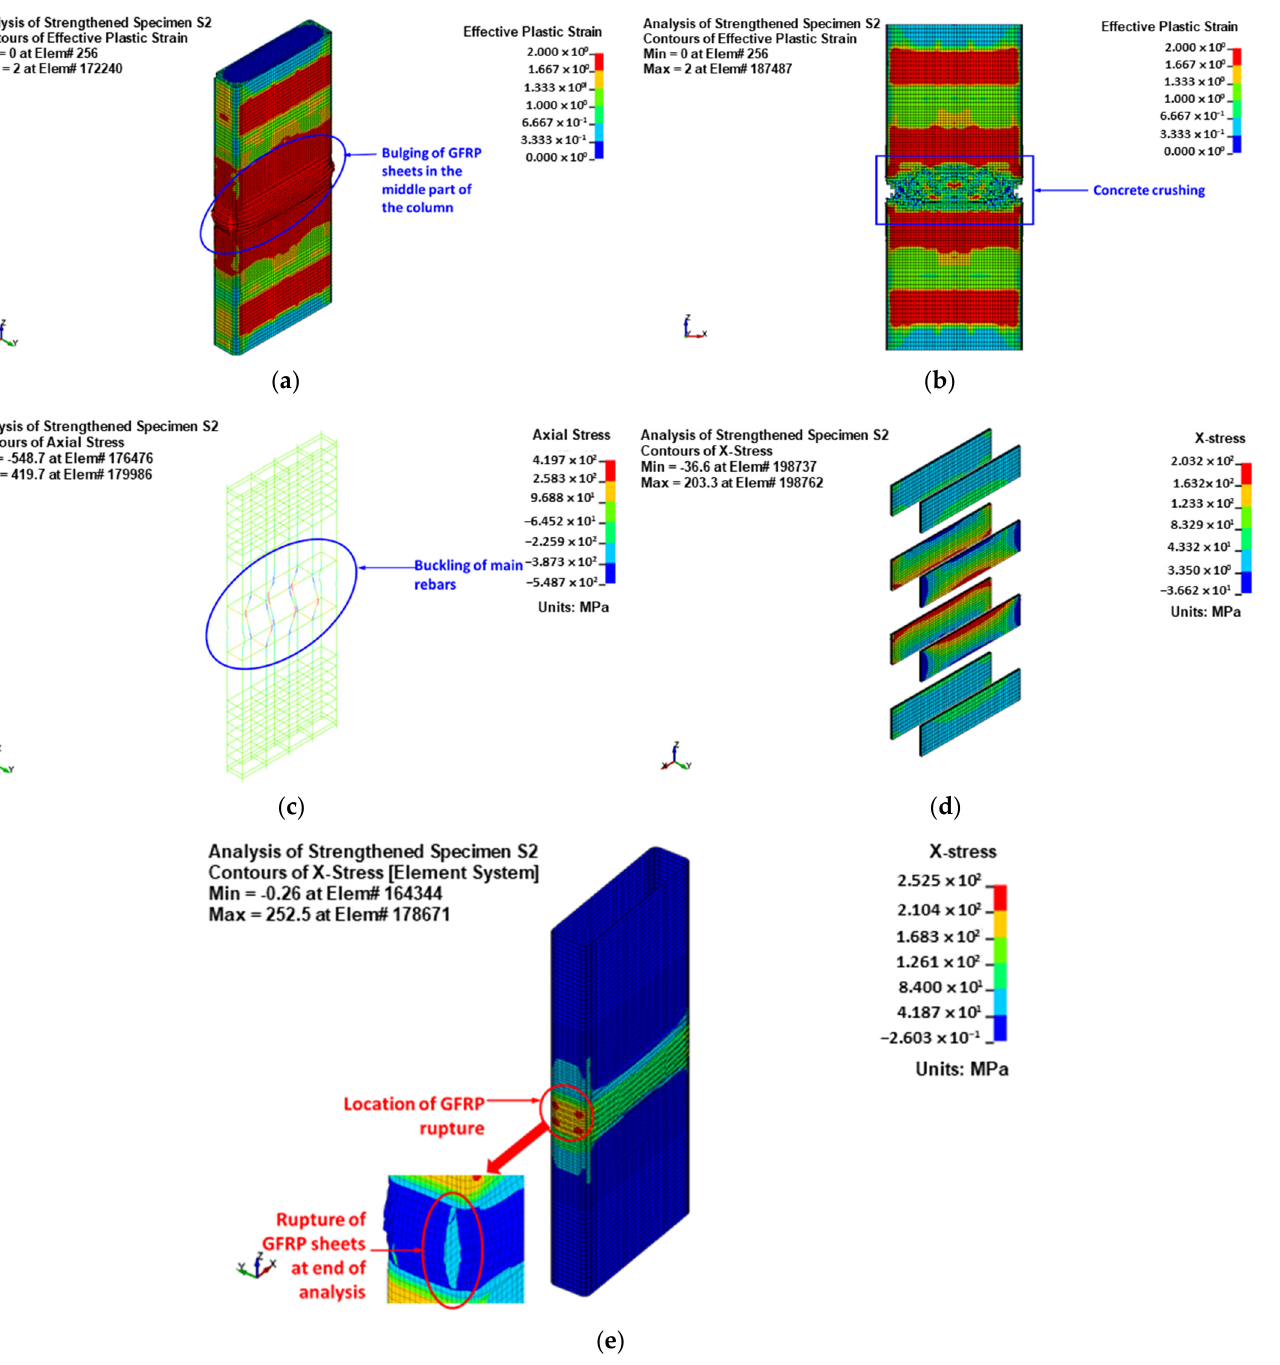
Figure 17. Numerically predicted failure mode for upgraded column S2: ( a ) bulging of GFRP sheets at maximum load; ( b ) concrete damage contours; ( c ) stresses in reinforcement cage; ( d ) stresses in steel plates; ( e ) stresses in the fi ber direction for GFRP sheets.